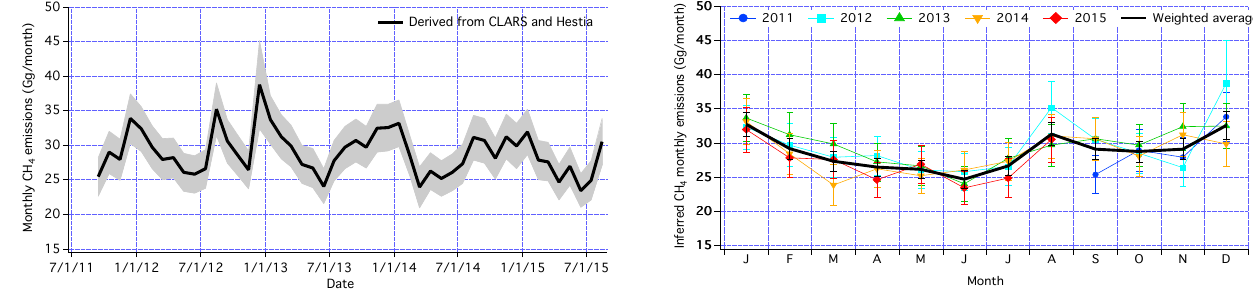
Figure 6. Time series of CLARS-FTS inferred monthly CH 4 emis- sions (in unit of Gg per month) and their 1 σ uncertainties from the Los Angeles Basin from September 2011 to August 2015. Overall uncertainties are propagated from the uncertainties in CLARS-FTS X CH 4 (XS) – X CO 2 (XS) regression slopes and CO 2 emissions.